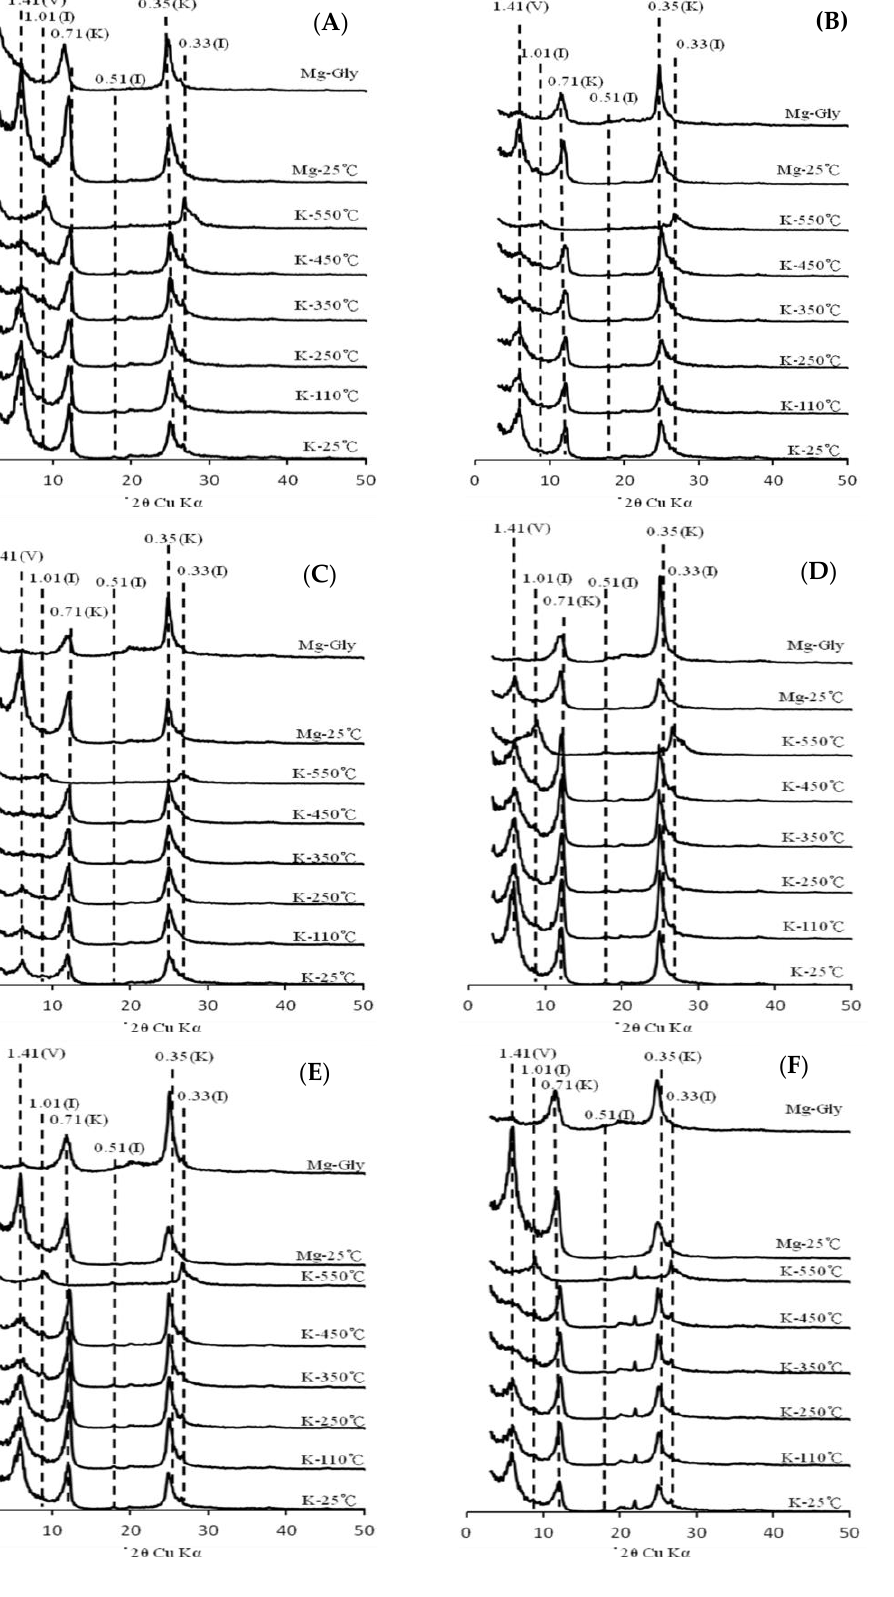
Figure 3. X-ray diffraction patterns of the ( A ) YLS (1), ( B ) YLS (2), ( C ) YLS (3), ( D ) YLS (4), ( E ) YLS (5) and ( F ) YLS (6) clay samples. Note: I: illite; K: kaolinite; V: